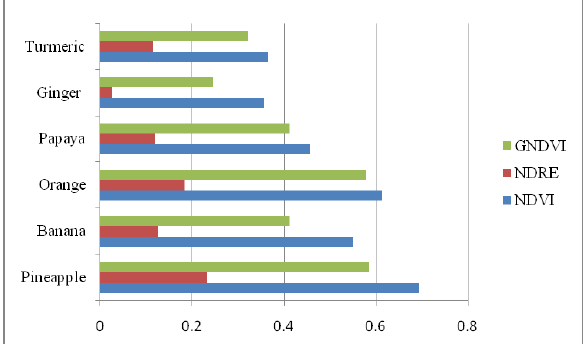
Figure 7. Mean values of vegetation indices for the selected horticultural crops